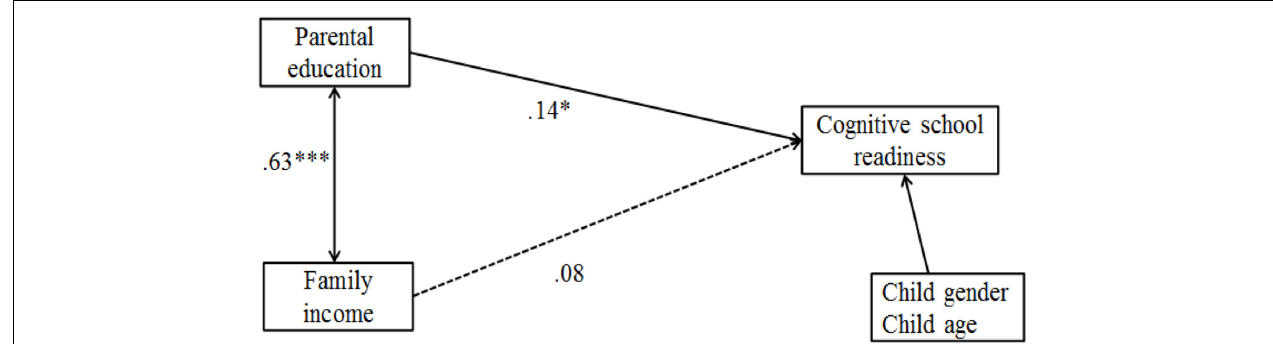
FIGURE 2 | The direct model. n = 307. Dotted line was used for insignificant paths. ∗ p < 0.05, ∗∗∗ p < 0.001.